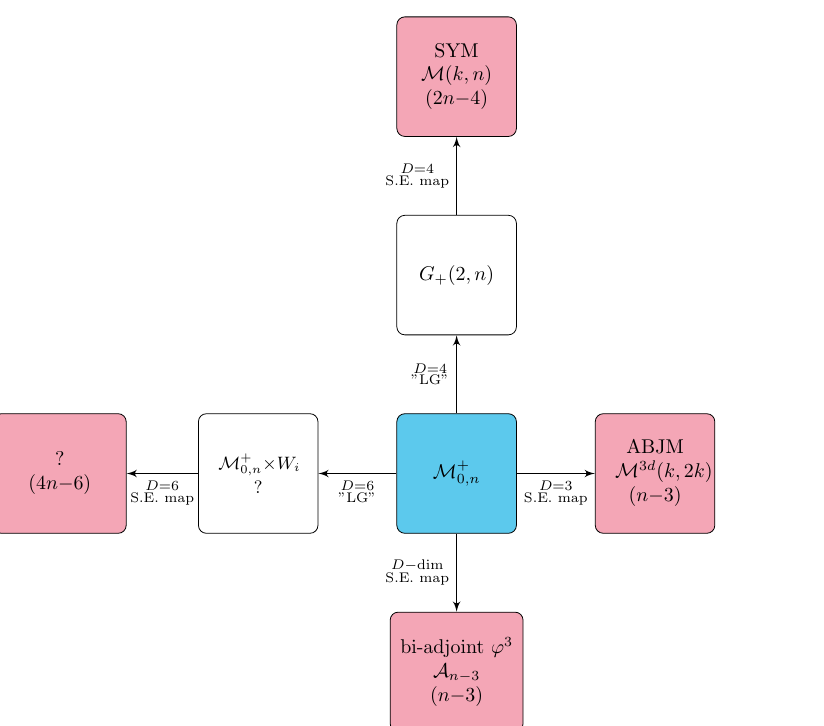
Figure 1 . Maps from moduli spaces to “amplituhedra” in general D and D = 3 , 4